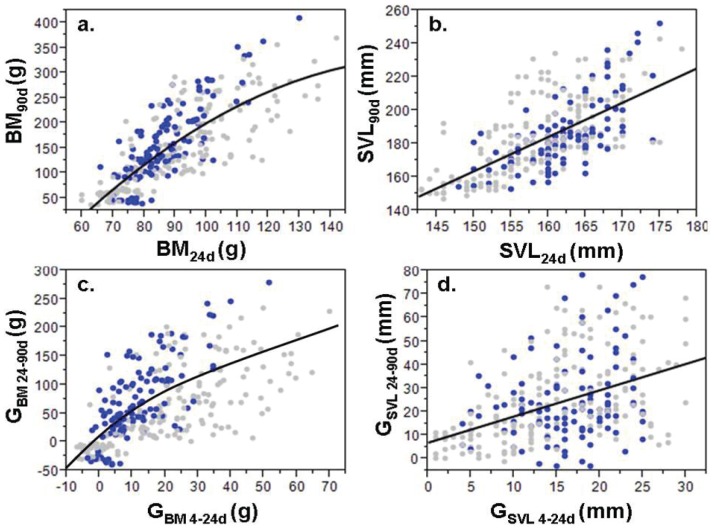
Relationship between size and growth of hatchling C. porosus (N = 300) at different ages.Relationship at 24 and 90 days: a) BM24d and BM90d, b) SVL24d and SVL90d, c) GBM4-24d and GBM24-90d, and d) GSVL4-24d and GSVL24-90d for hatchlings born early (N = 120; blue) and late (N = 180; grey) in the year.